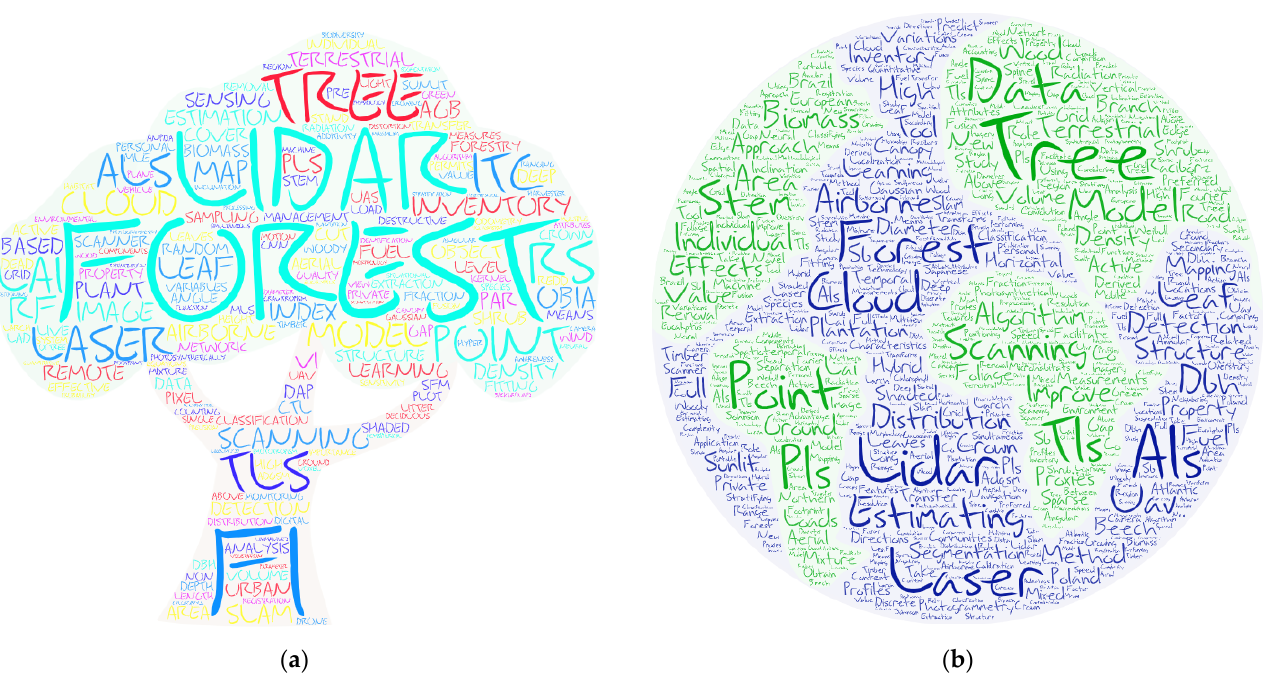
Figure 1. Pictorial word clouds showing the main thematic topics of the 30 research papers included in the Special Issue “3D Point Clouds in Forest Remote Sensing” of Remote Sensing (created with https://wordart.com/create, accessed on 17 June 2021): ( a ) Keywords; ( b )